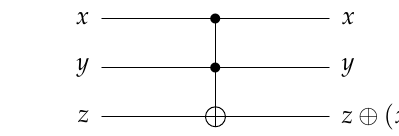
Figure 1. Quantum gates: CNOT ( left ) and Toffoli ( right )